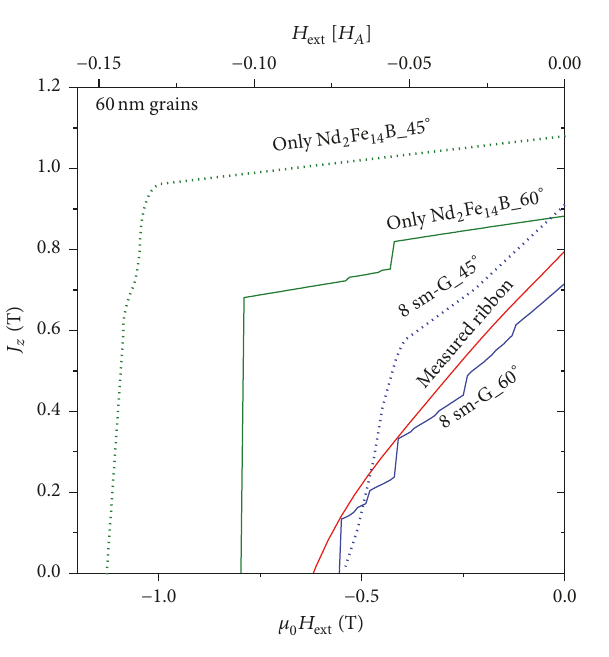
Figure 13: Comparison of the measured demagnetization curve of the Nd-Fe-B nanocomposite melt-spun ribbon with calculated curves for directly coupled only hard magnetic grains (only Nd 2 Fe 14 B) and for the model structure with 8 soft ferromagnetic grains and 21 Nd 2 Fe 14 B grains (8 sm-G). 45 ∘ and 60 ∘ denote the average misorientation of the granular model structure. The average grain size is 60nm.